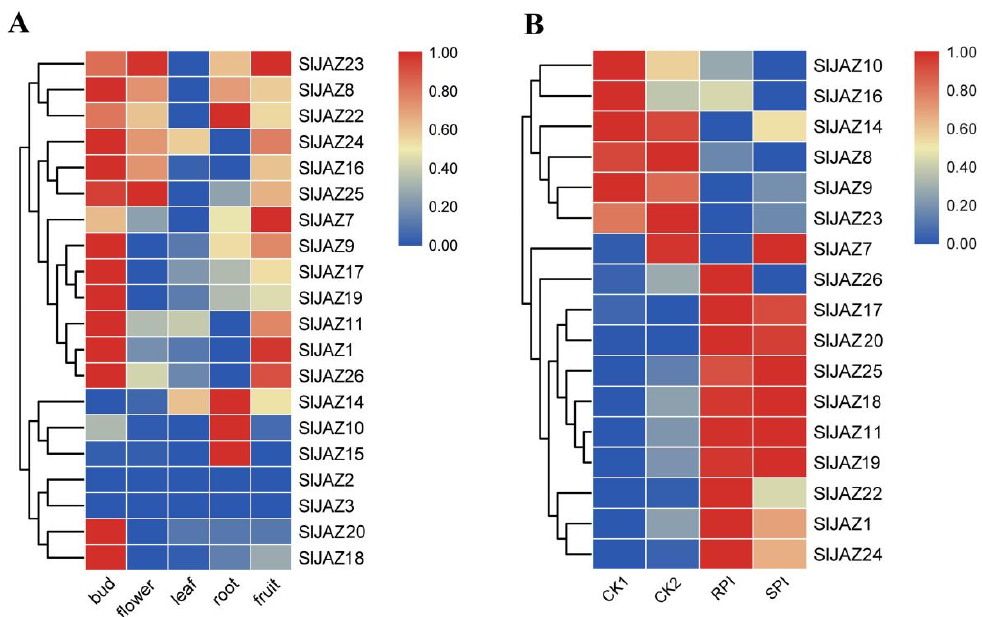
Figure 7. Expression profiles of SlJAZ genes in tomato. ( A ) Expression patterns of SlJAZ genes in different tomato tissues and organs. ( B ) Expression profiles of SlJAZ genes in plants inoculated with S. lycopersici and in CK plants. The relative transcript levels of SlJAZ s in the RNA-seq data were plotted after Z-score normalization was performed across the rows based on the absolute FPKM value of each gene. The colors from blue to red represent the range of the relative expression levels from low to high, respectively.